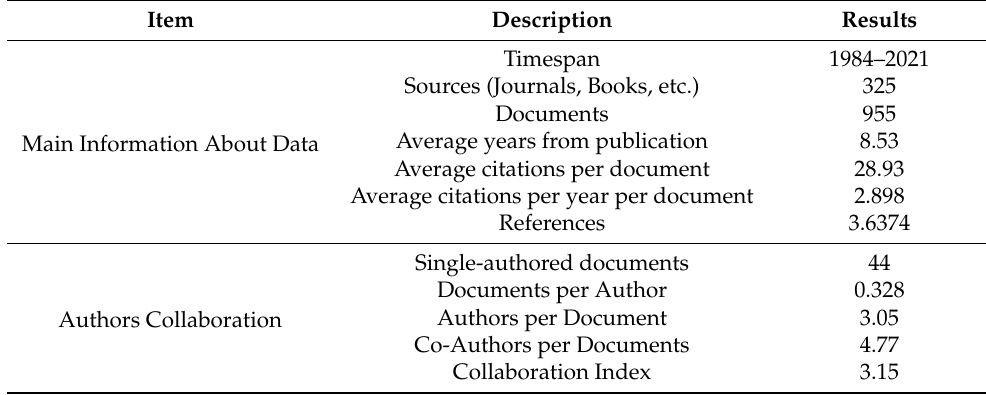
Table 4. Citations metrics.